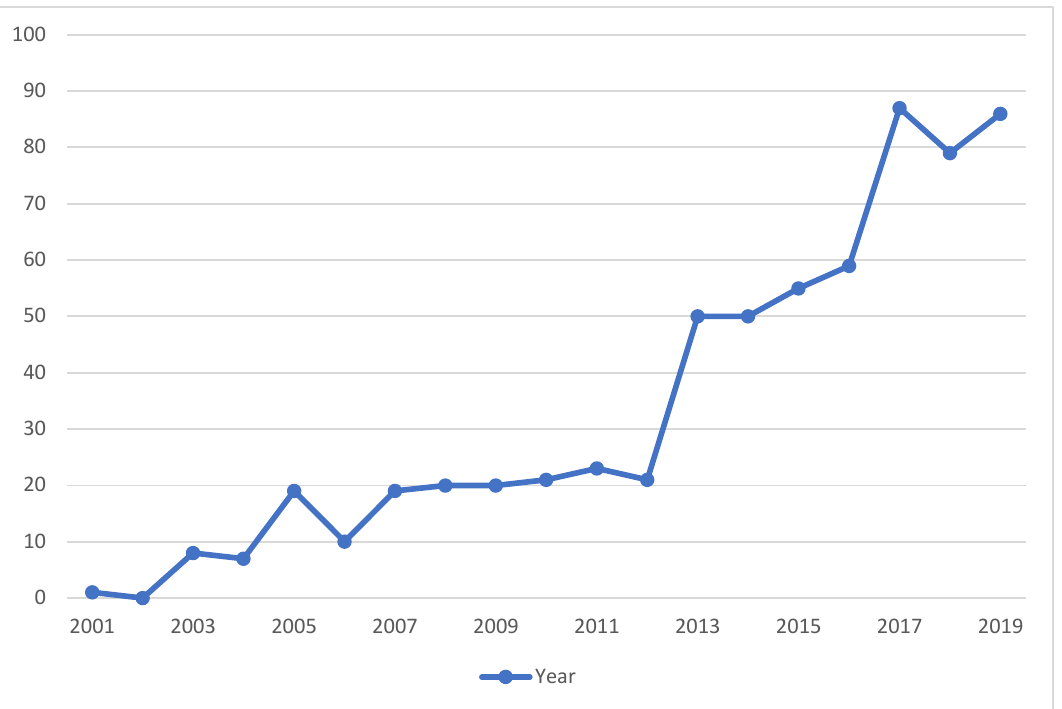
Figure 4. Trends of publications in the common area of the business models and the foods from 1999 to 2019.